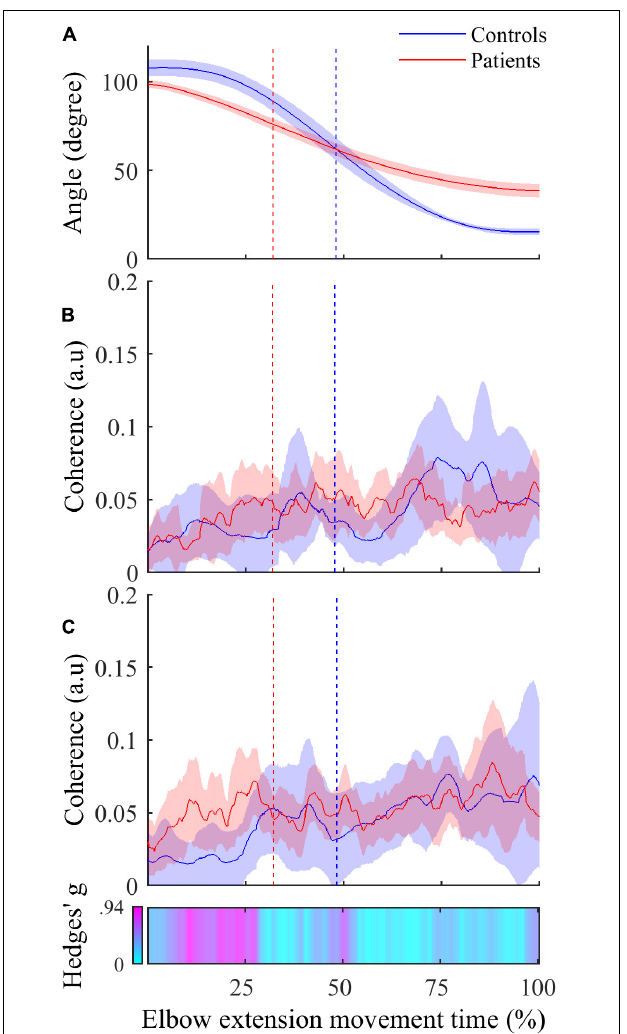
FIGURE 4 | (A) Active elbow extension angle (mean ± 95% CI) as a function of time expressed in percent for controls (in blue) and patients (in red). (B) Mean instantaneous CMC with agonist TB muscle (mean ± 95% CI) as a function of time expressed in percent for controls (in blue) and patients (in red). (C) Instantaneous CMC with antagonist BA muscle (mean ± 95% CI) as a function of time expressed in percent for controls (in blue) and patients (in red). In (C) , CMC is higher in patients in more than half the acceleration phase and not different in deceleration phase when using non-corrected p -values ( α = 0.05). Instantaneous Hedges’ g, representing effect size of the CMC difference are shown as a horizontal bar with values ranging from 0 (cyan) to magenta (0.94). In all graphs, the vertical dashed lines represent the boundary between the acceleration and the deceleration phases for controls (in blue) and patients (in